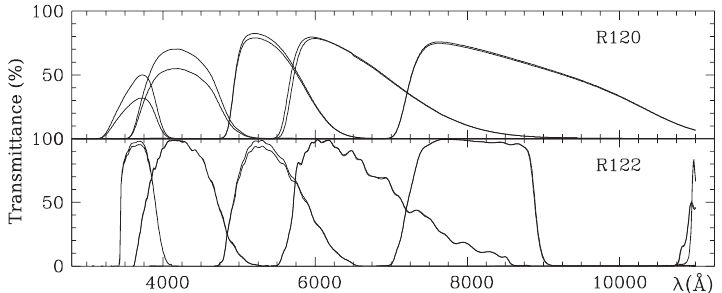
Fig. 9. Top panel. Transmittance of the Schuler filters of the ANS telescope R120 before and after cleaning (after a year of normal use). Bottom panel. The change in transmittance of the Astrodon filters of the ANS telescope R122 after 18 months of normal use (both sets of curves before